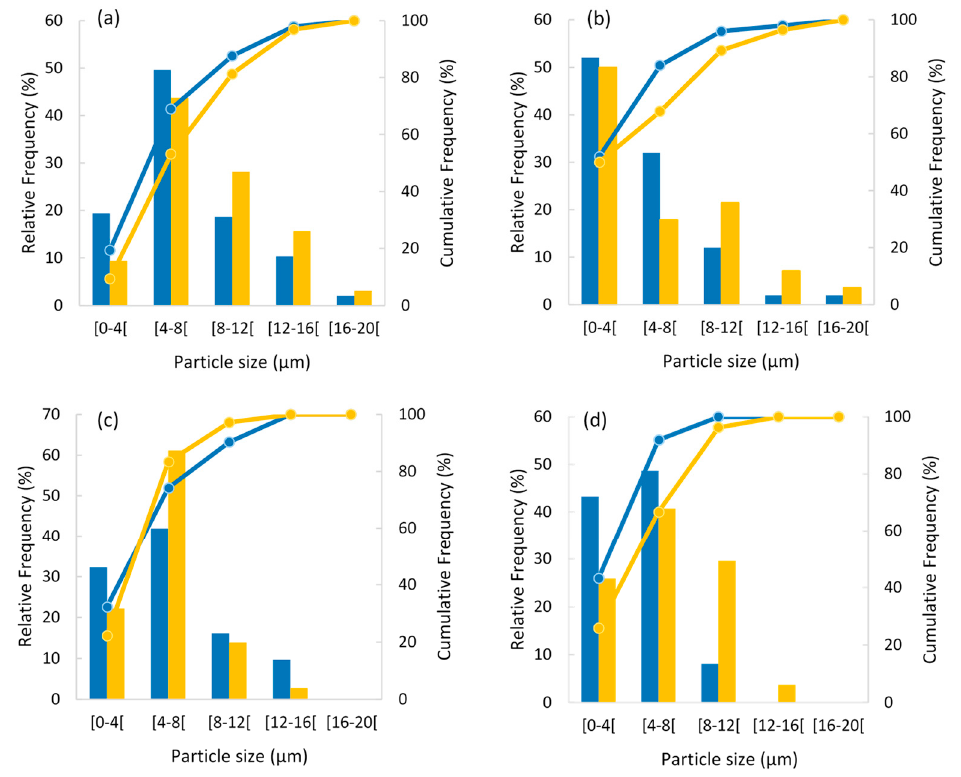
Figure 2. Relative frequency (bars) and cumulative frequency (lines) of the particles’ diameter: ( a ) maltodextrin with extract, ( b ) arabic gum with extract, ( c ) maltodextrin without extract, and ( d ) arabic gum without extract, dried with an inlet air temperature of 150 °C (blue color) and 190 °C (yellow color).